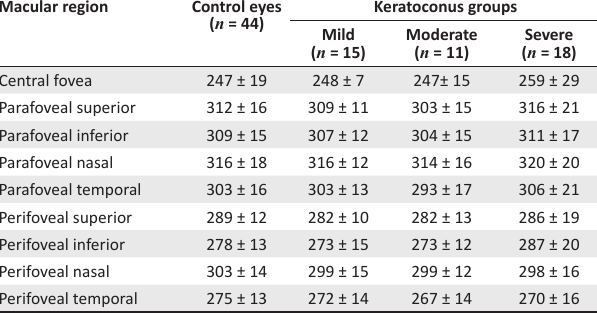
TABLE 2: Means and standard deviations for macular thickness ( µ m) in the nine Early Treatment Diabetic Retinopathy Study sectors in the four study groups. Macular region